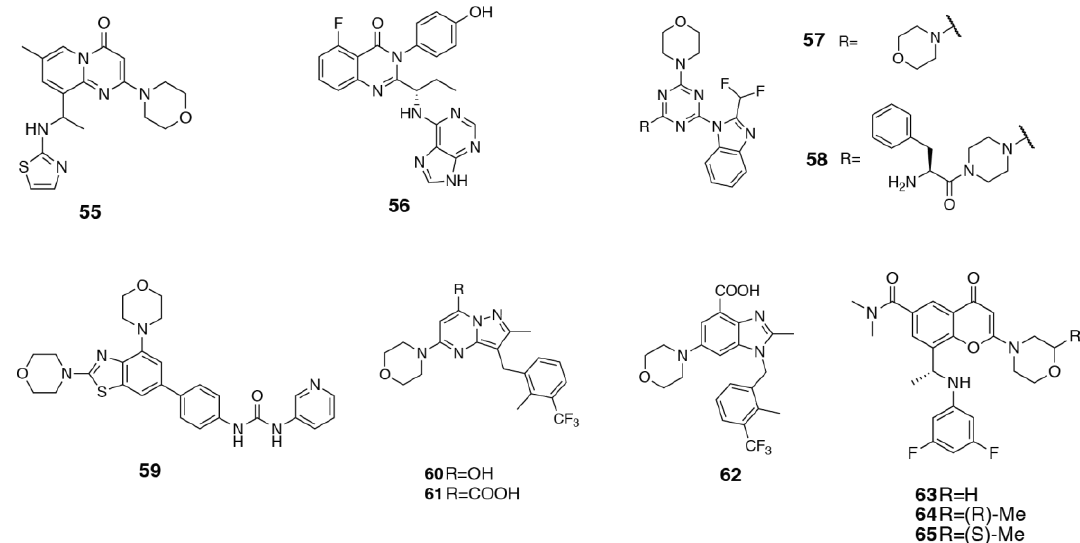
Figure 10. Structures of PI3K β selective inhibitors 55 – 65.